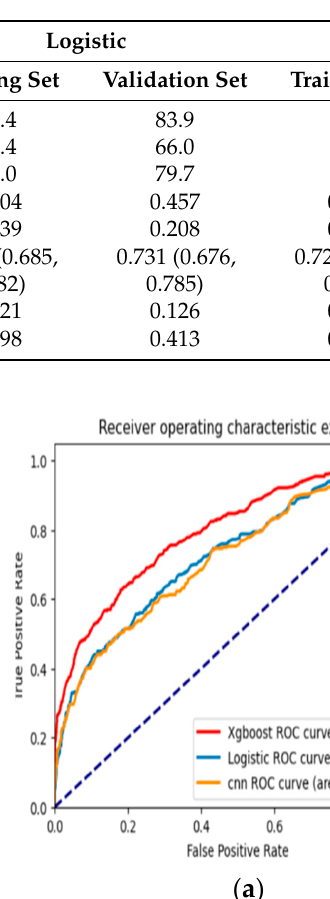
Table 3. Performance of the three models.